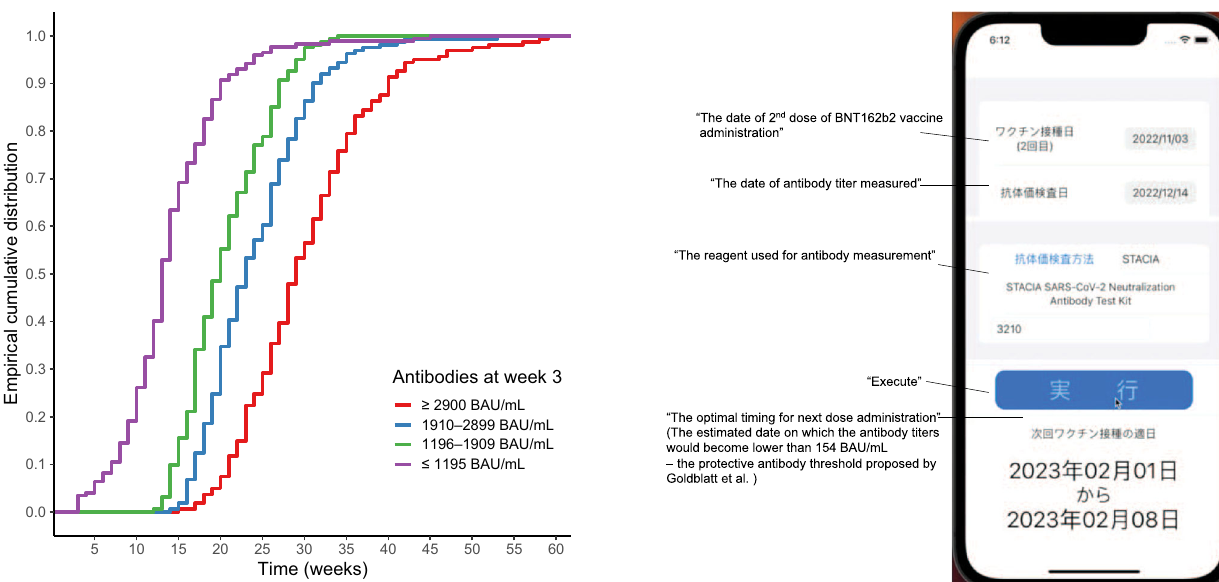
Fig. 3 Empirical distribution functions of predicted results of time instants at which antibody titers fall below the positive threshold. Empirical distribution functions of the lower limit of the 95% pre- diction interval for each participant falling below the 154 BAU/mL threshold for classi fi cation as a protective antibody titer, strati fi ed by antibodies (anti-receptor-binding domain IgG) at week 3 ( N = 657). The cutoffs for antibodies at week 3 were determined based on the 25th, 50th, and 75th percentiles. following vaccination, far more complicated processes such as transcription, antigen presentation, and antigen-speci fi c immune cell inductions are included than in the kinetics of other medications, such as antibiotics. Regarding the application of pharmacodynamic models to antibody dynamics, Favresse et al. 14 discussed the suitability of the one-compartment model for antibody waning over 3 months after BNT162b2 vaccination. However, the present study demonstrated better predictability using the two-compartment model as compared with the one-compartment one. Two-compartment models are often used as pharmacodynamic models that have two different distribution areas, such as plasma